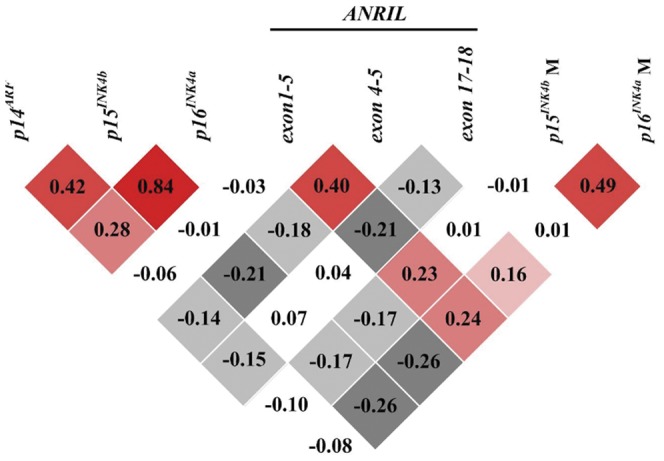
Correlation among p15INK4b/p16INK4a methylation and gene expression on chromosome 9p21.Red regions indicate positive significant correlation and grey regions indicate inverse significant correlation, while no significant correlation is shown as white.